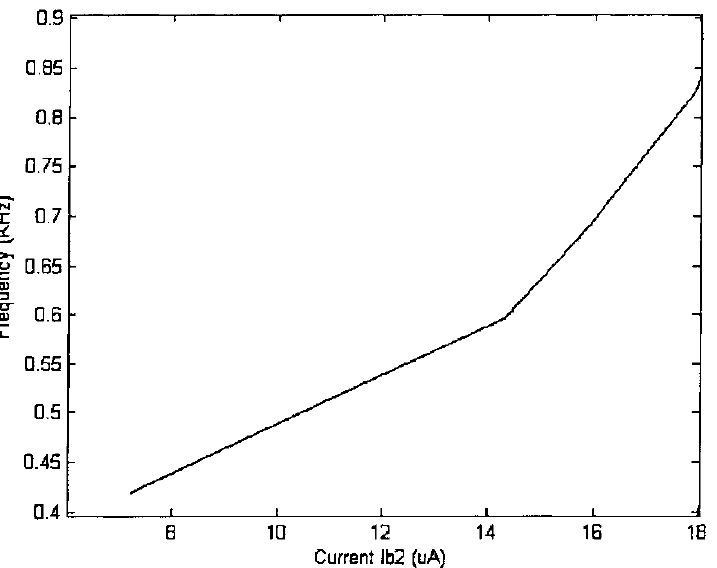
FIGURE 3 Variation of the sawtooth frequency with the control current I b2 . V CC ¼ 5V, C ¼ 30nF, I b1 ¼